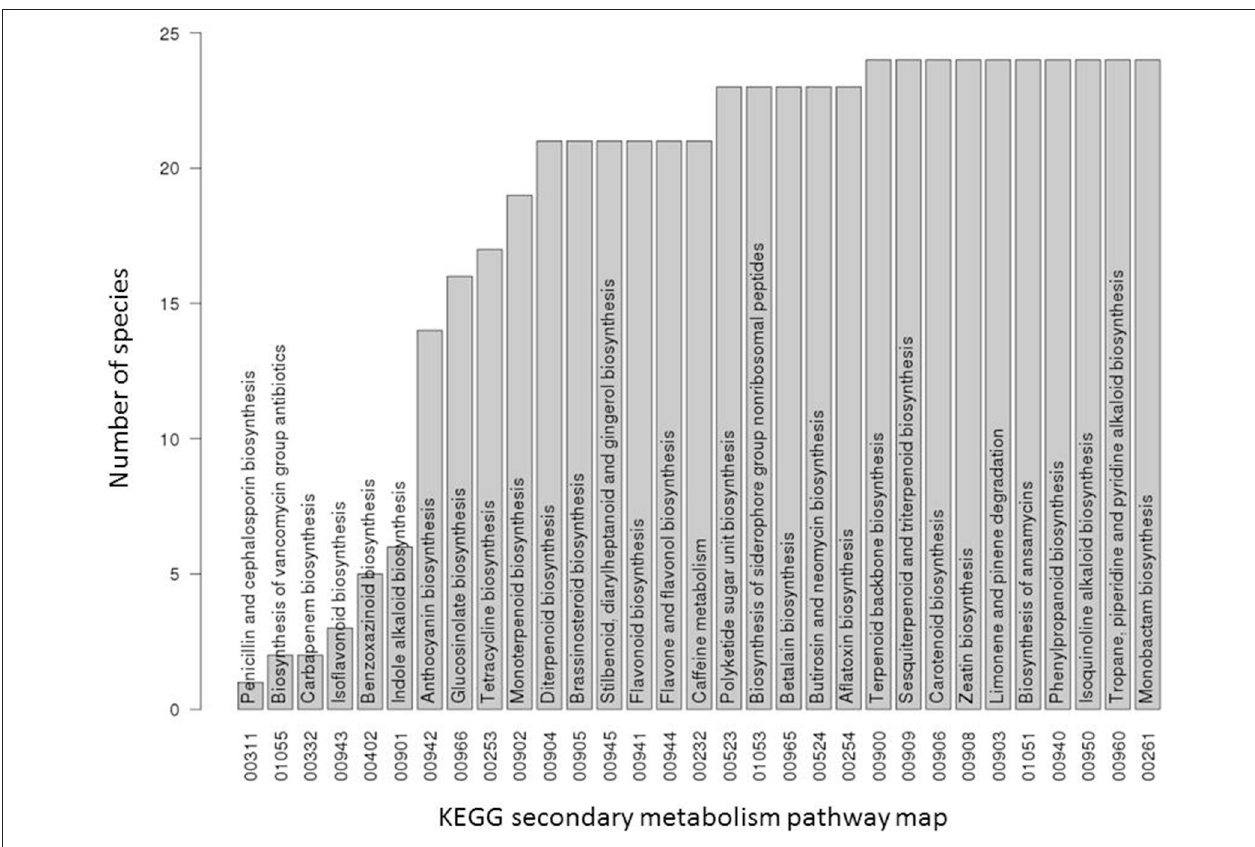
FIGURE 1 | Occurrence statistic of secondary metabolite pathways in 24 KEGG species. For each secondary metabolic pathway of the KEGG database, the number of plant species containing it out of all 24 plant species used in this study are displayed. A pathway was considered present in a given species if at least one enzyme gene from this species was assigned to this